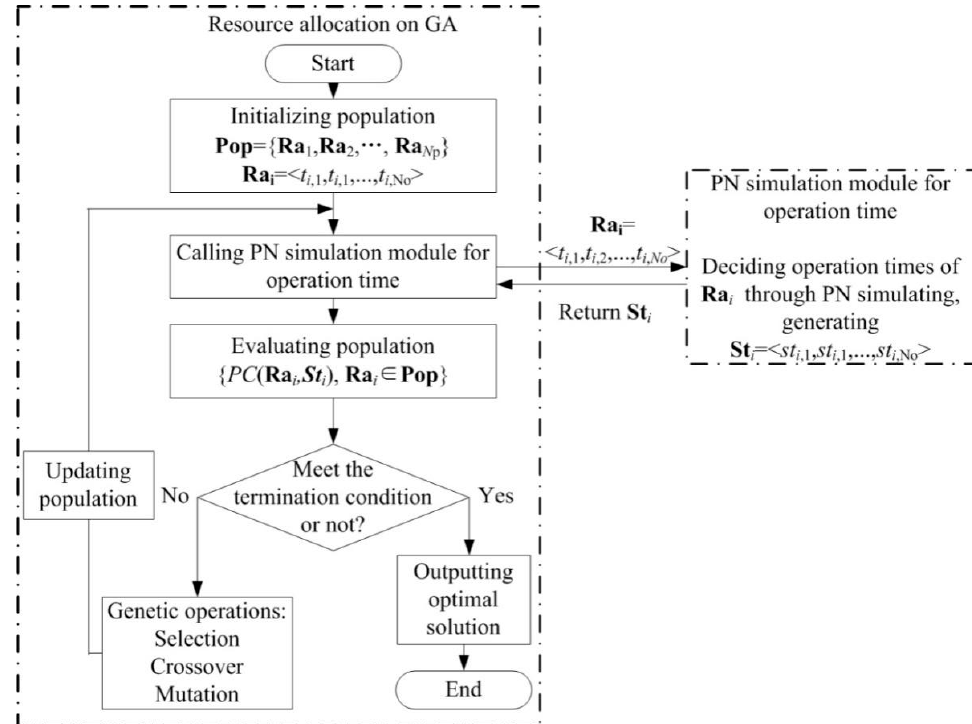
Figure 5. Framework of the GAPN approach for the FJSP ‐ IT.